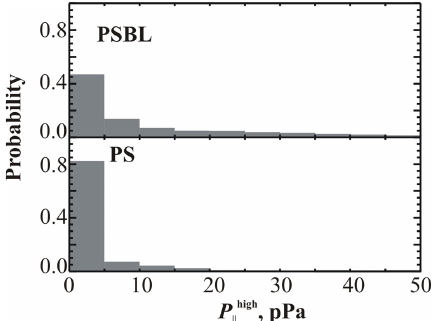
Fig. 6. Scatterplot of the plasma β versus the ion density calculated for the entire energy range. The samples measured within the PSBL are shown by blue dots, and those measured in the outer PS region are displayed by red dots.